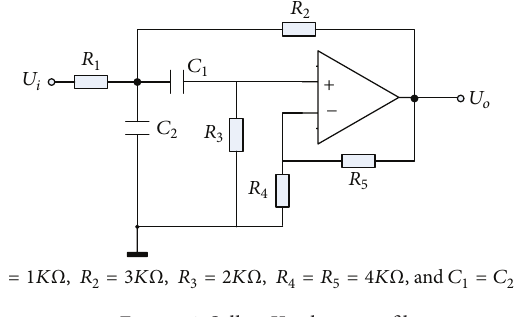
Figure 1: Sallen-Key low pass filter. Table 2: Result of comparative assessment.